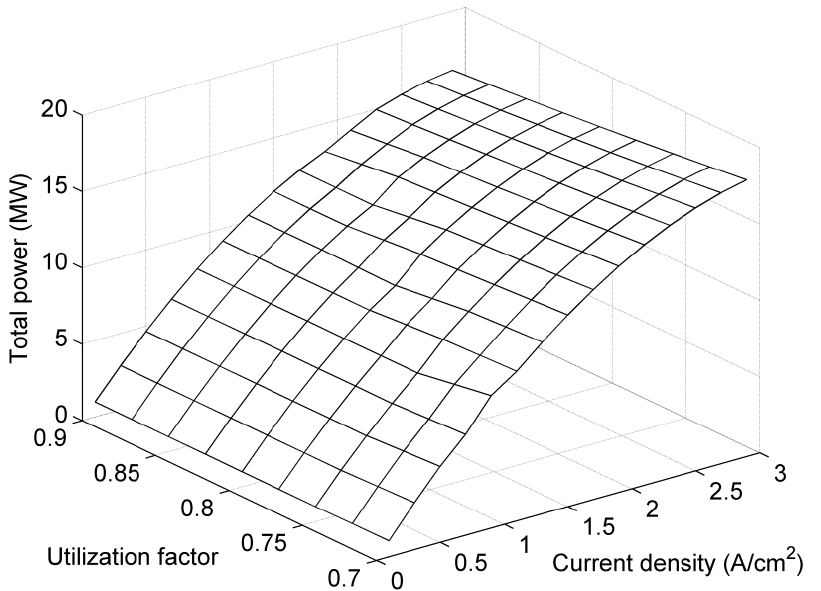
Figure 10. The effect of current density and fuel utilization factor on the total power output of the SOFC-GT; T = 600 °C and r = 4. FC p